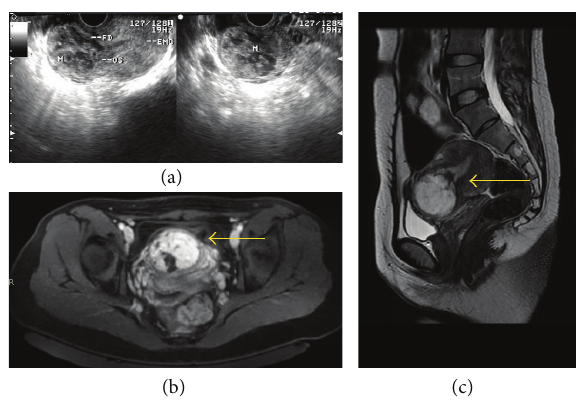
Figure 2: (a) Transvaginal gray-scale ultrasonography revealing an irregulargestationalcysticmass(FD)locatedwithintheisthmicarea of the lower anterior wall of the uterus and protruding toward the uterine cavity. (b) Obvious and homogenous enhancement of the gestational sac after Gd-DTPA administration on axial T1-weighted imaging (arrow) without enhancement of the inner content. (c) Huge gestational sac (4.9cm × 4.0 cm × 4.4 cm) showing high signal intensity on sagittal T2-weighted imaging (arrow) with low signal intensity